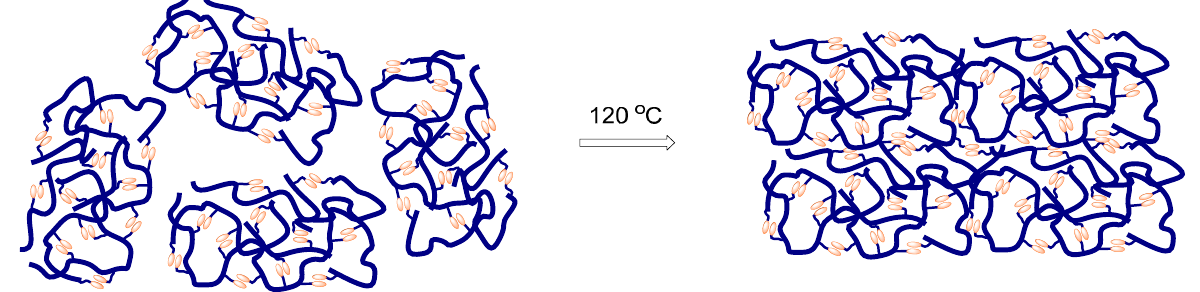
Figure 19. Frequency dependences of G ′ , and G ″ for polymers 3 a ( top ) at 160 °C and after cooling